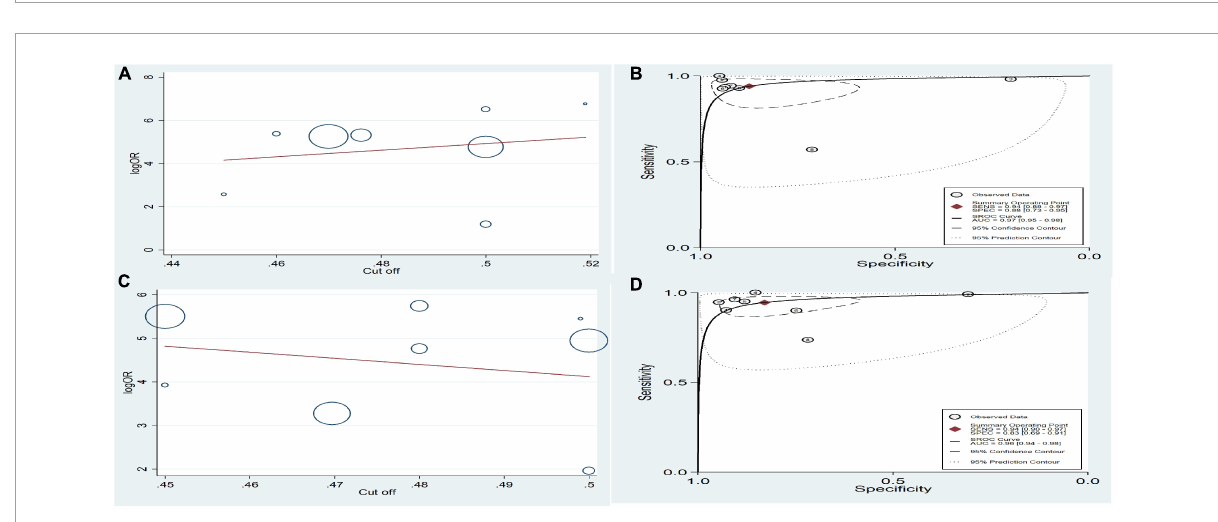
FIGURE3 Forest plots for the diagnostic accuracy of overall cutoff point.